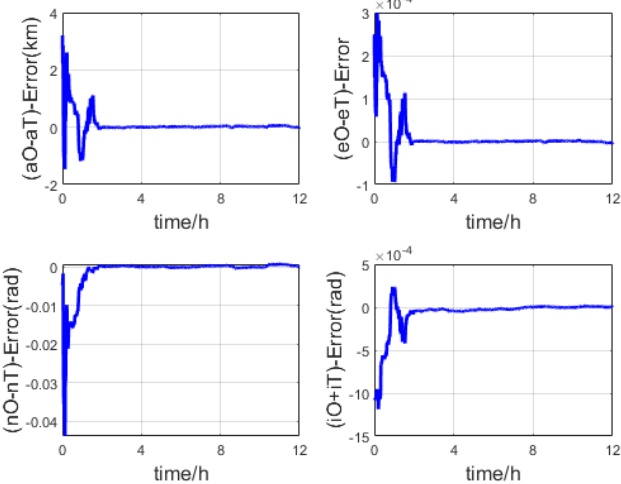
Figure 5. Estimation errors of orbit element combinations in the symmetric case.